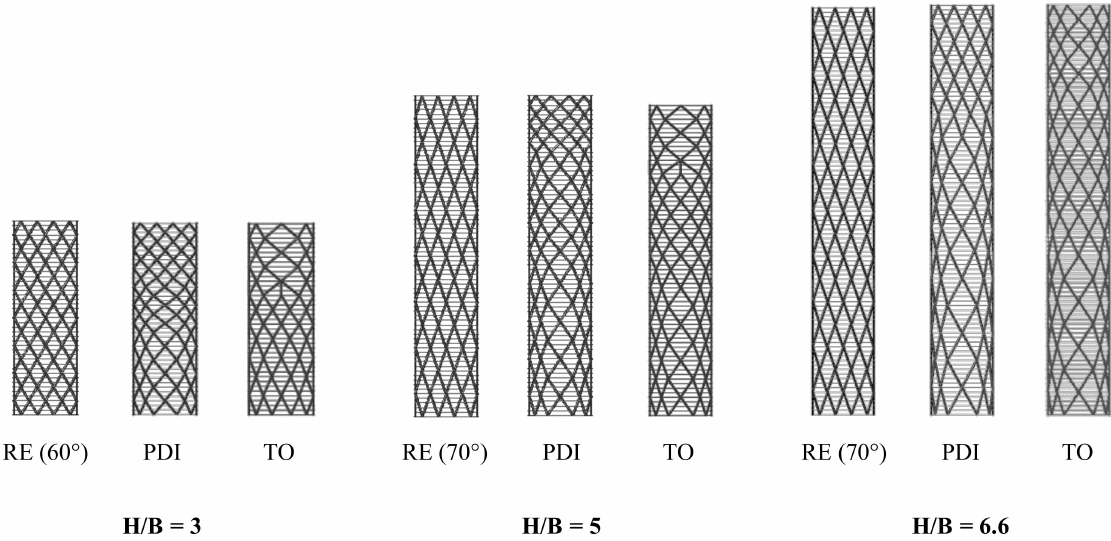
Figure 13. Structural patterns: (RE) regular, (PDI) Principal Direction Inspired, (TO) topology